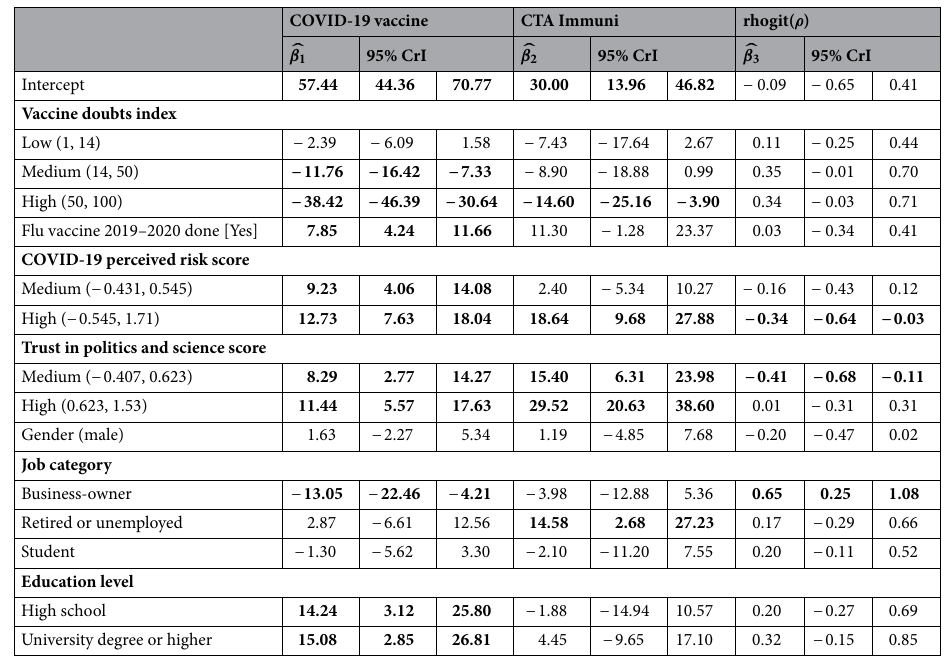
Table 2. Adjusted coefficients and 95% CrI estimated by a Bayesian bivariate Gaussian regression model for the position parameter ( µ 1 and µ 2 ) the score of likelihood to get a COVID-19 vaccine and to download CTA Immuni, and their correlation rhogit( ρ ) respect to the reference category. In bold 95% CrI outside the null effect. Adjusted also by age with penalized cubic splines with 5 equally spaced knots (Fig. 3). Reference category: Vaccine doubts index (No doubt), Flu vaccine 2019–2020 done (No), COVID-19 perceived risk score (Low), Trust in politics and science score (Low), Gender (Female), Job (Employee), Education level (Middle